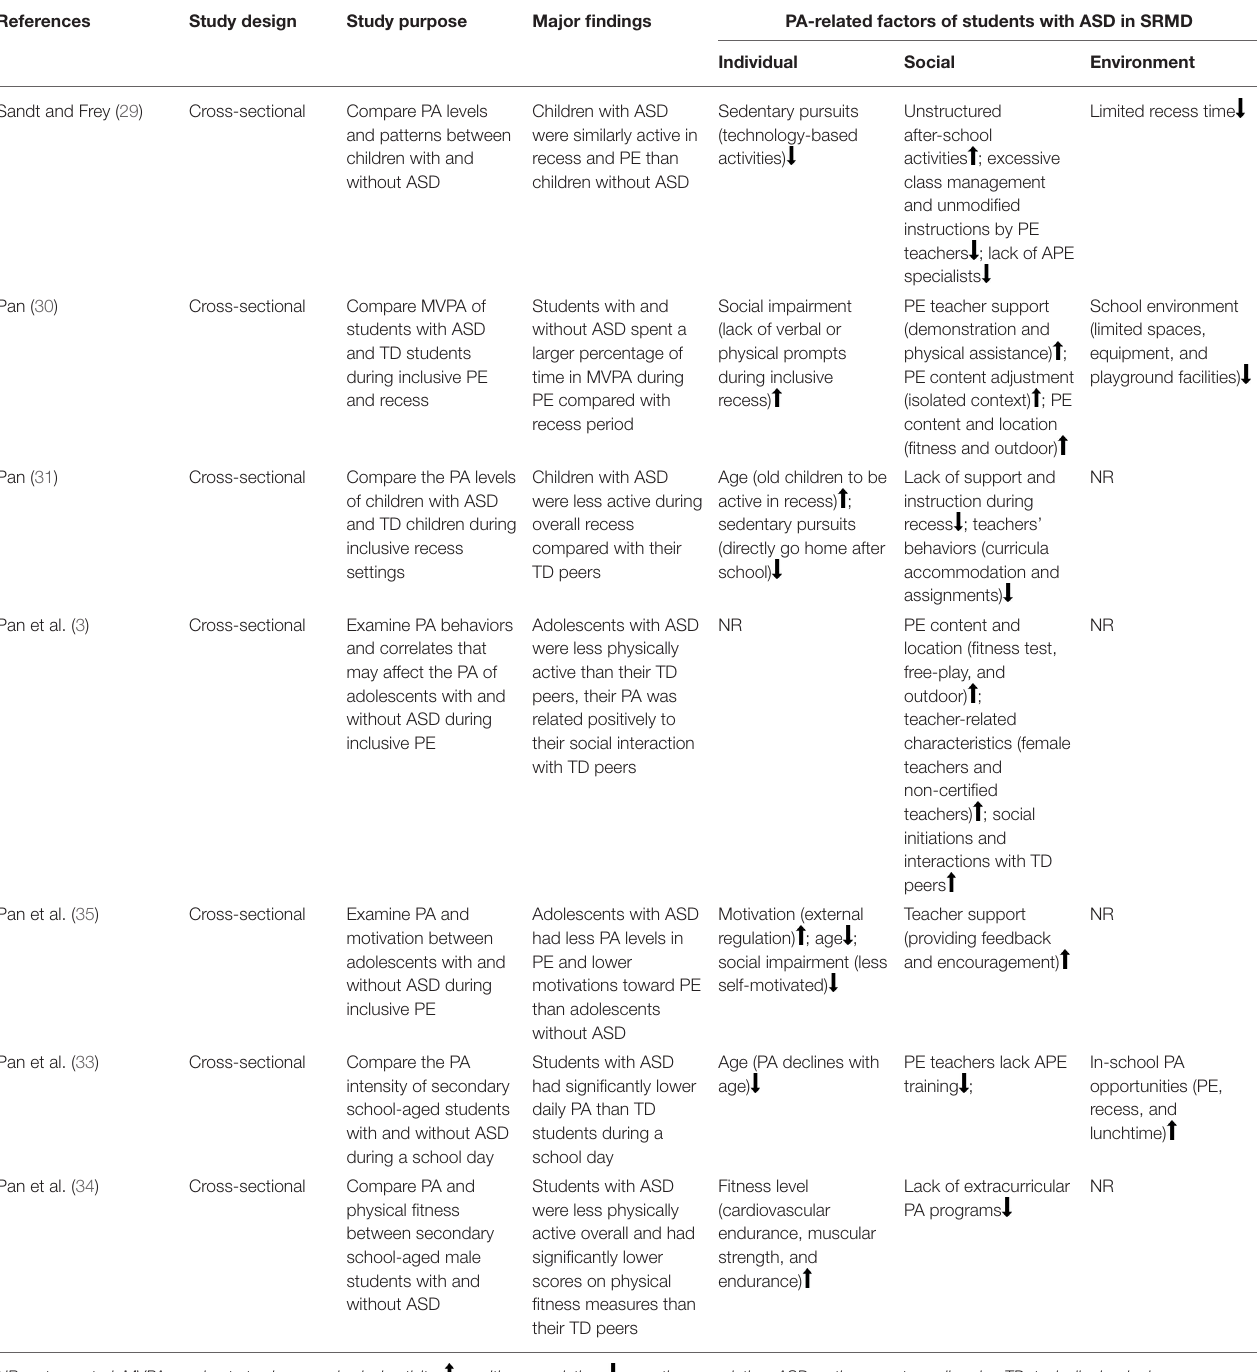
TABLE 2 | Summary of included studies on physical activity (PA)-related findings in inclusive